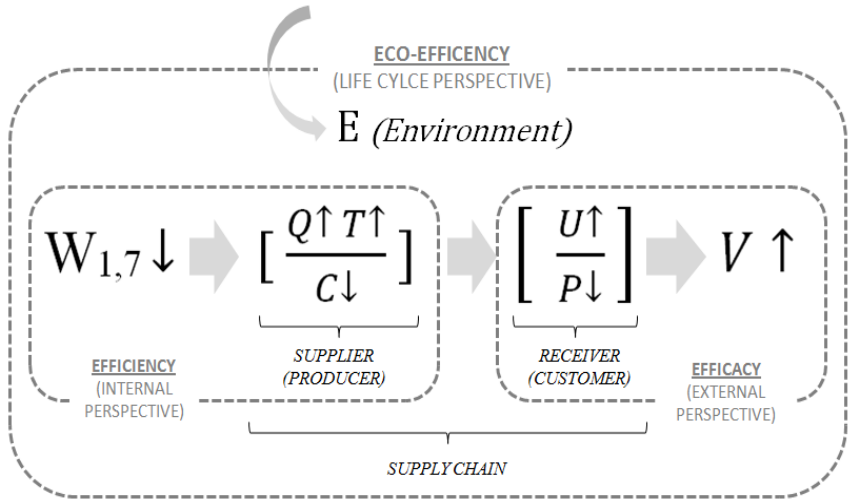
Figure 3. Manufacturing variables in the perspective of